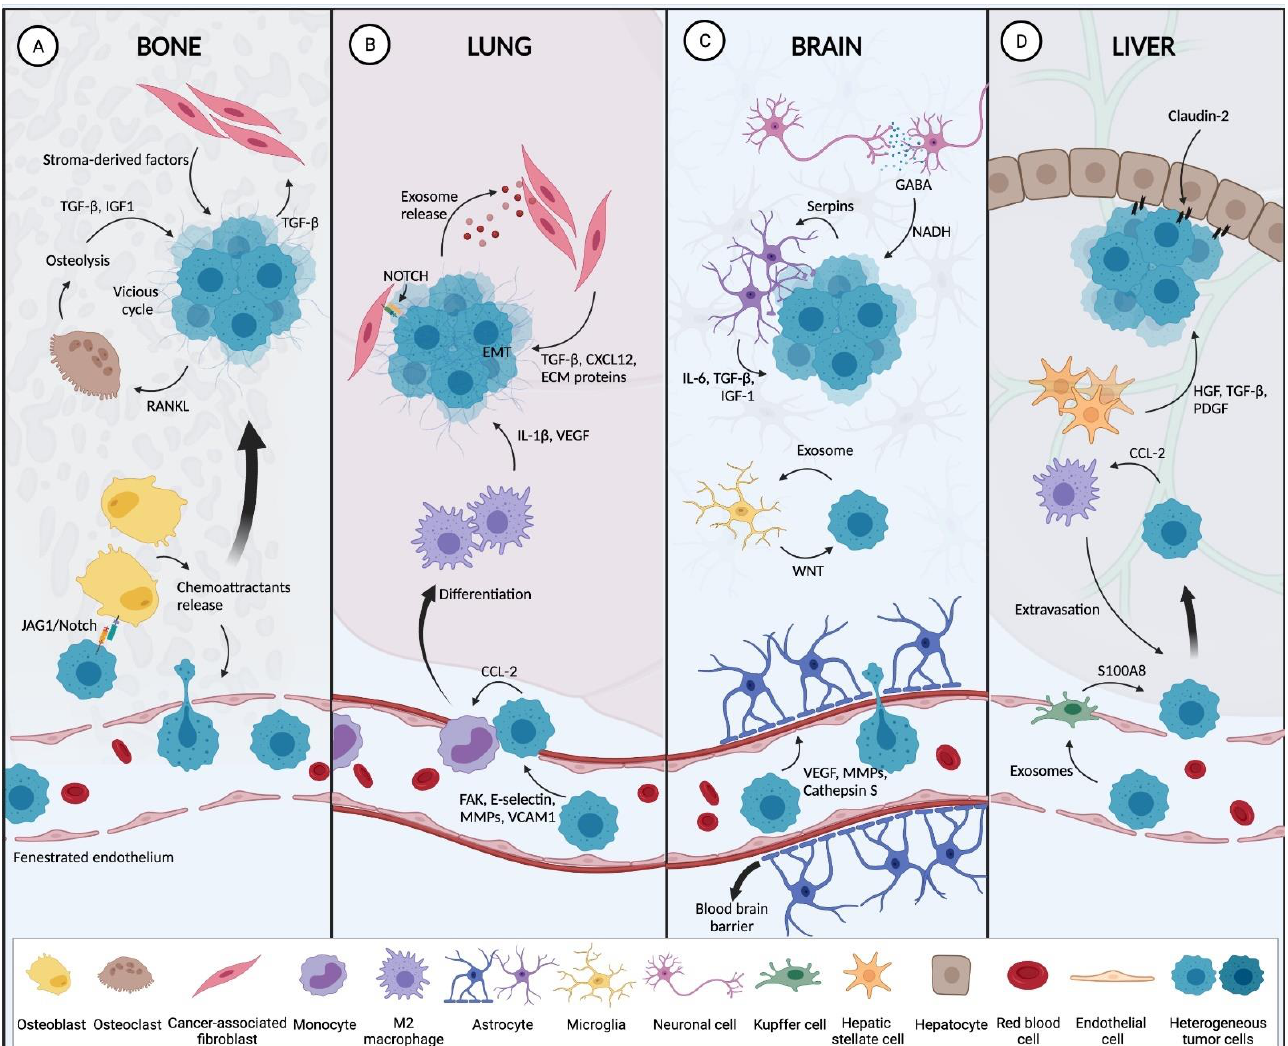
Figure 2. Host stromal cells at the metastatic site promote the establishment of the breast tumor. ( A ) In the bone microenvironment, chemoattractant released by osteoblasts recruit circulating tumor cells (CTCs) from the circulation to extravasate into the bone stroma. Once in the bone environment, interactions between BC cells and osteoblasts occur via JAG1/Notch and CAFs (through TGF- β ), facilitating bone metastasis. There, BC cells then secrete factors to promote osteolysis,